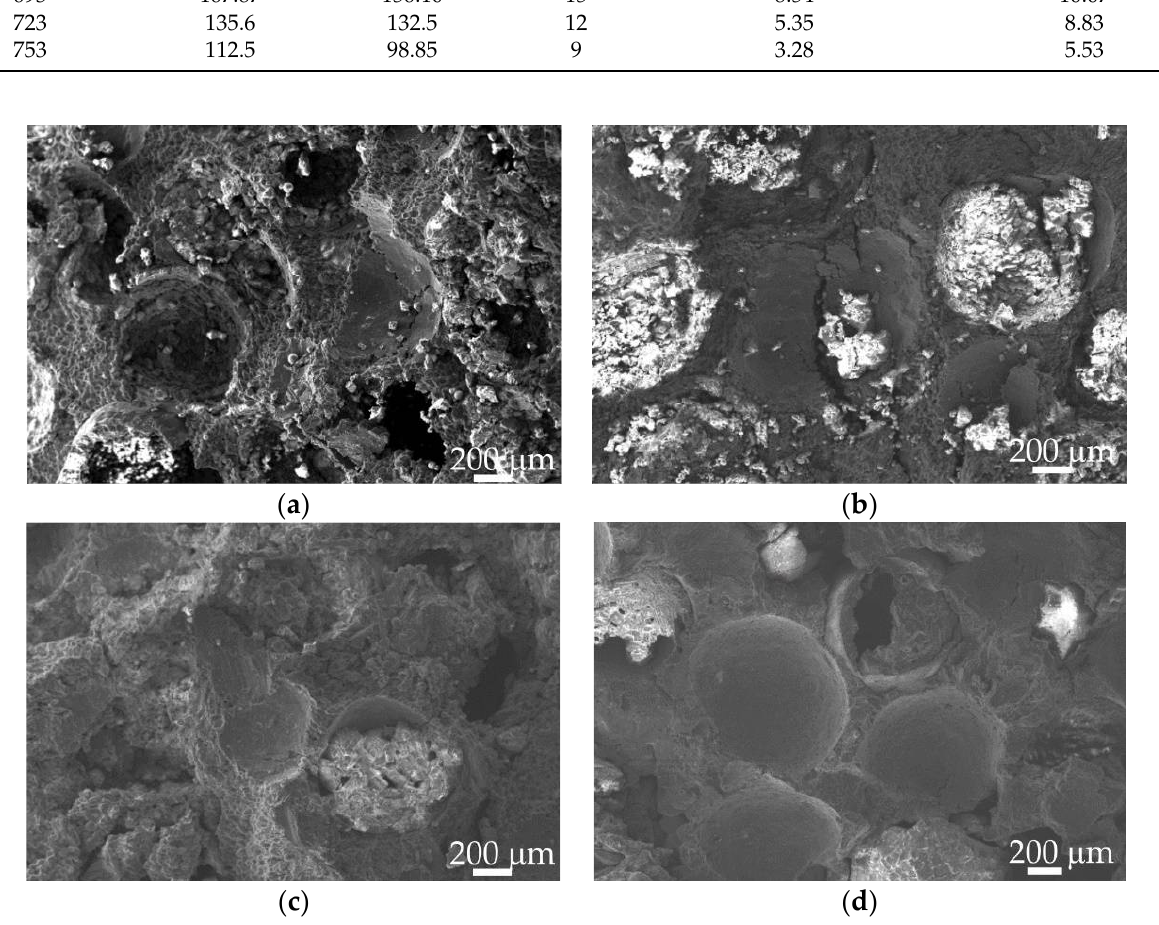
Figure 11. Fracture morphology at cross section of the Al 2 O 3hs /AZ91D syntactic foams prepared at different sintering temperatures after dynamic compact: ( a ) 663 K, ( b ) 693 K, ( c ) 723 K, and ( d ) 753 K.